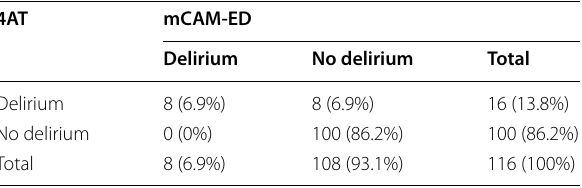
Table 3 Cross table of the 4AT results based on the mCAM-ED assessments